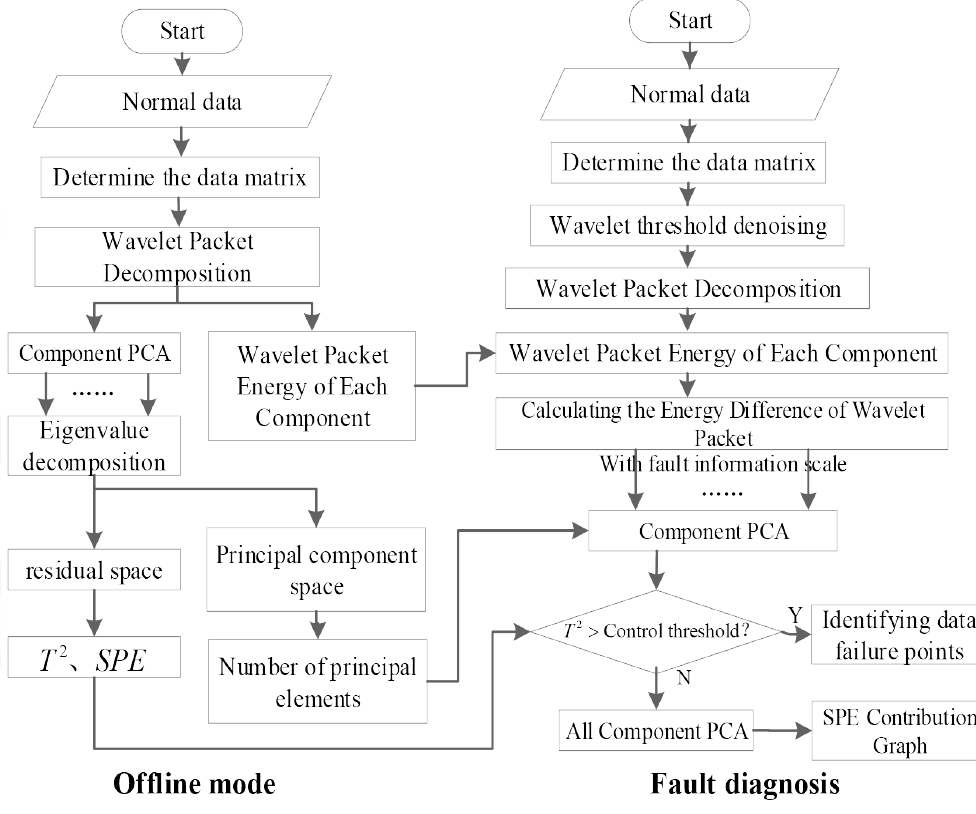
Figure 5. The flow chart of the improved